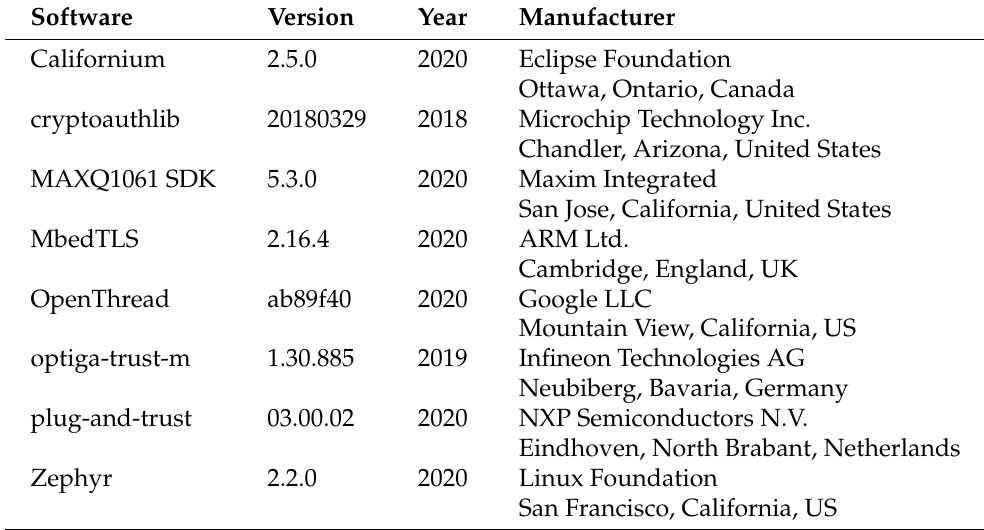
Table A4. Software versions of the used libraries and